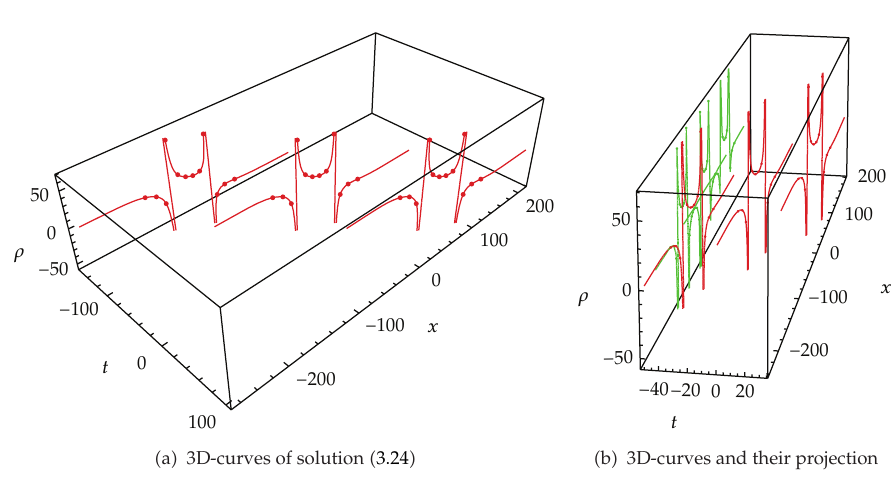
Figure 7: Evolvement graphs of 3D-curves along with the time and their projection